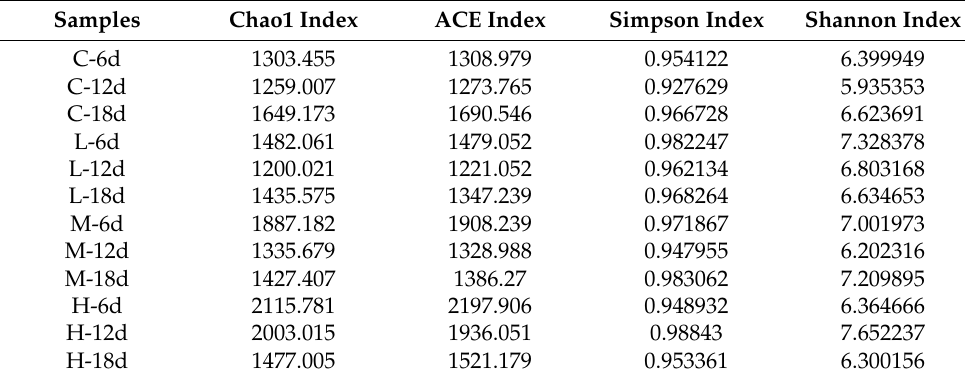
Table 1. Comparison of α -diversity indices for eukaryotic communities under different times. C: the sediment with no paroxetine added; L: 10 µ g/L paroxetine; M: 100 µ g/L paroxetine; H: 1000 µ g/L paroxetine. Samples Chao1 Index ACE